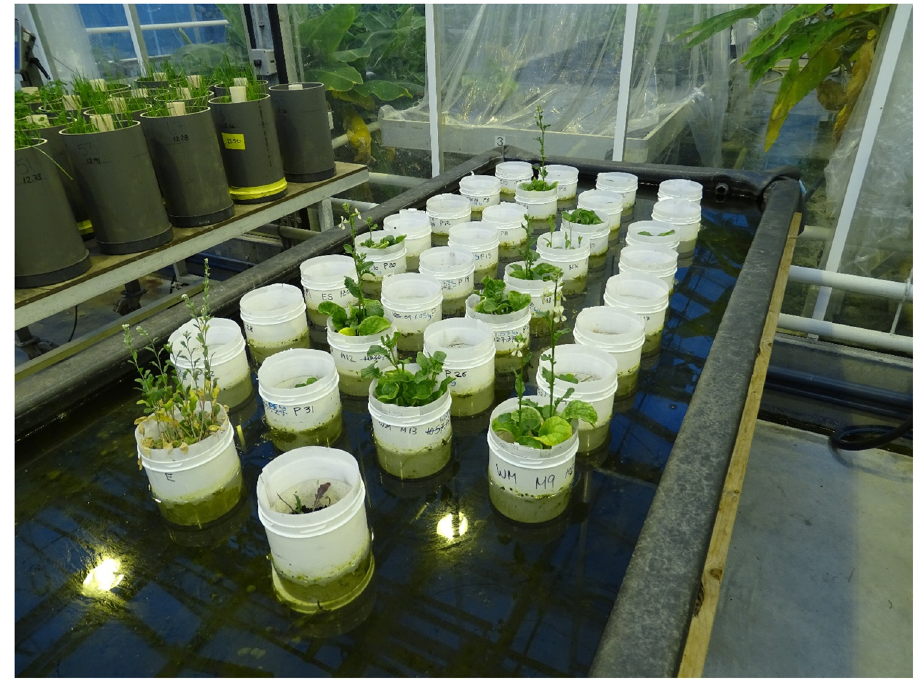
Figure 1: Set up of the experiment. Pots and treatments were placed randomly in the water bath. The photo shows the pots placed in a cold - water bath for optimal temperature conditions of the soil for the worms. A schematic diagram of the pot set up can be found in Appendix Figure